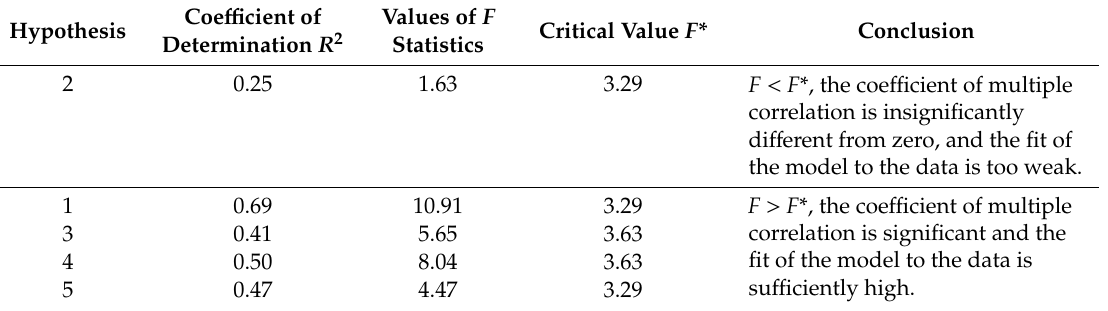
Table 3. Values of F statistics for the hypotheses.